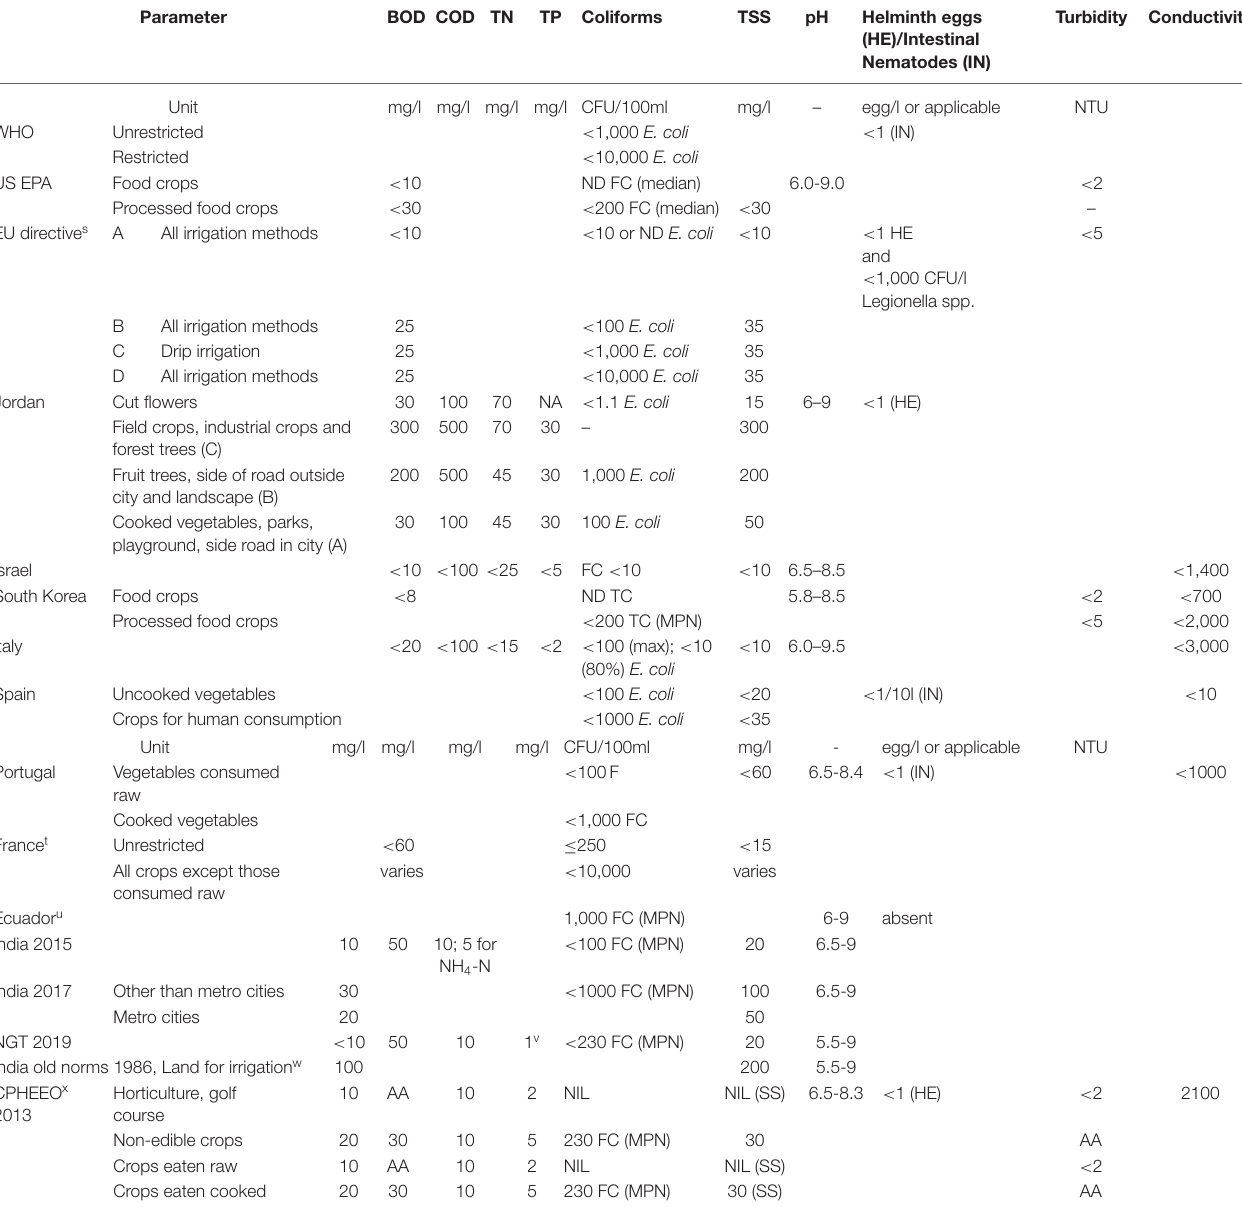
TABLE 9 | Wastewater reuse standards in different countries (MoEFCC, 1986b, 2015, 2017b; MWI, 2012; CPHEEO, 2013; Ministerio del Ambiente, 2015; Hanseok et al., 2016; European Commission, 2019a; National Green Tribunal order,